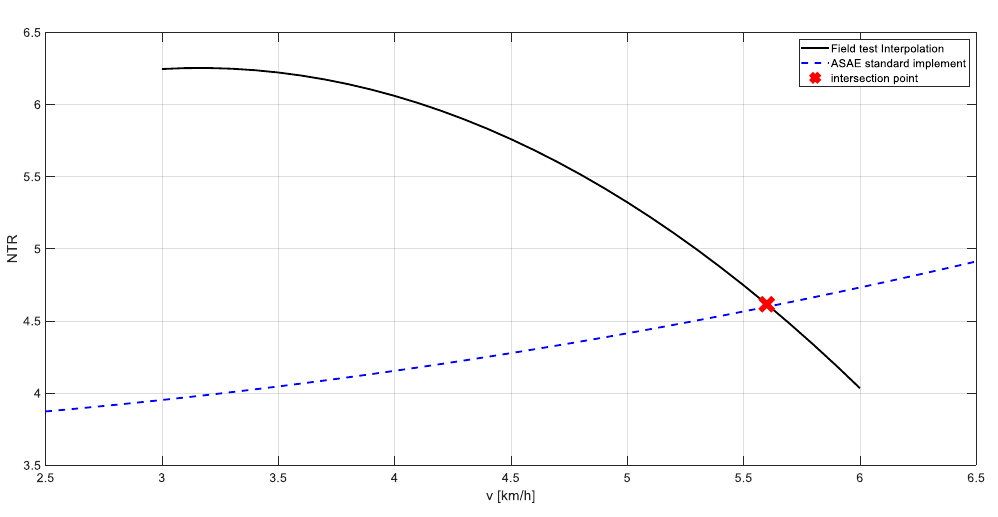
Table 5. Regression curve for NTR as a function of v (TT in 8th gear).